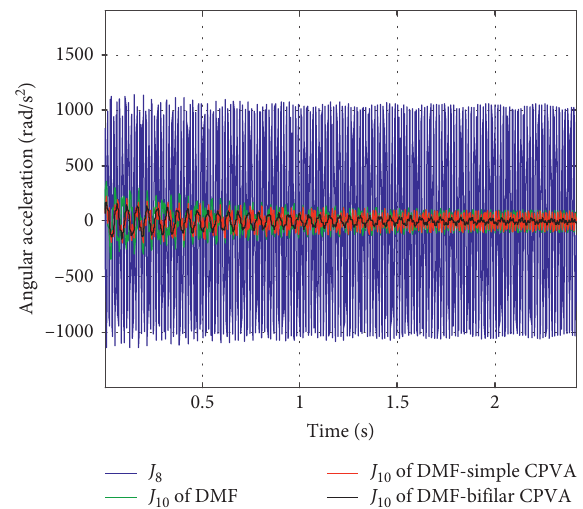
8 and J 10 at 2000r/min